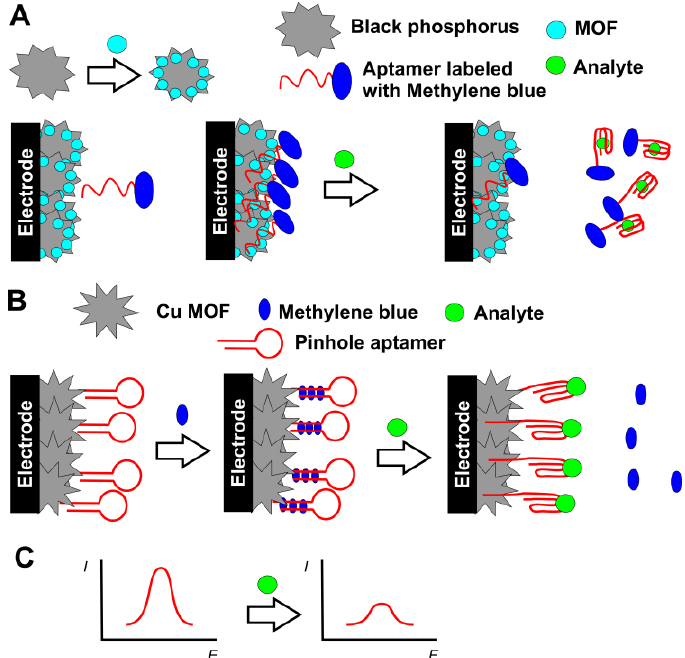
Figure 10. ( A ) Displacement protocol for determination of phosphoprotein 1 with methylene blue-labeled aptamer; ( B ) Determination of E. coli with pinhole aptamer saturated with methylene blue; ( C ) Changes in the DPV signal of methylene blue corresponded to the analyte binding.